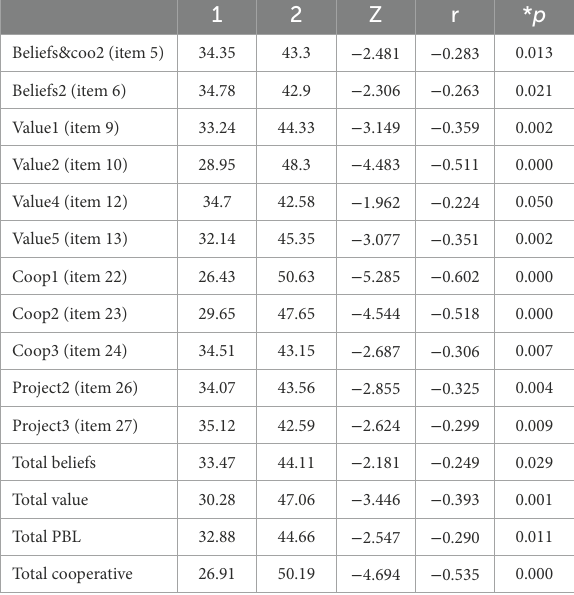
TABLE 12 U Mann–Whitney analysis to assess how motivation is affected by center type.